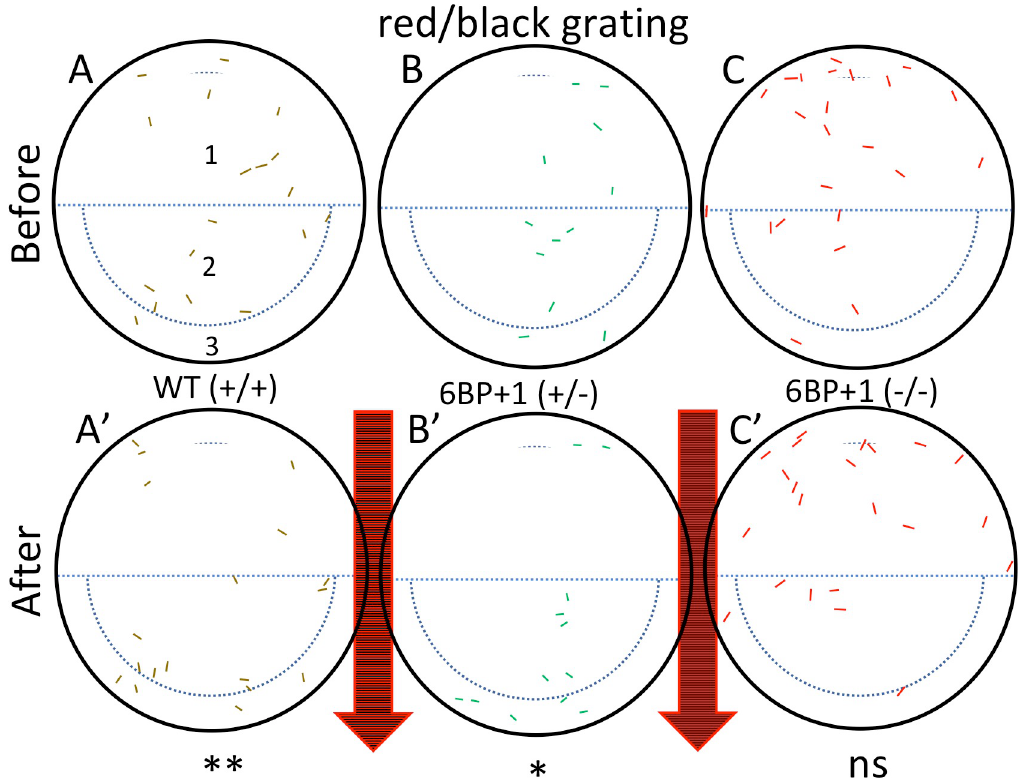
Fig 12. Optomotor response test using a red and black stimulus. The wild type (N = 18 larvae) (A, A’) and heterozygote (N = 12 larvae) (B, B’) larva moved with the stimulus as seen in the white/black drifting gratings (Fig 11). (C, C’) The mutant larvae (N = 23 larvae) did not move with the red/black stimulus and remained scattered. The experiment was repeated 2 times, with similar outcomes in each trial. Significance is calculated with the Fisher Exact Test using data from both trials (Table 3). https://doi.org/10.1371/journal.pgen.1008869.g012 These genotypes show that red-cone signals alone are sufficient for OMR in wildtype and 6BP +1 heterozygote fish, but the absence of red cones prevents a response in the 6BP+1 mutant fish.